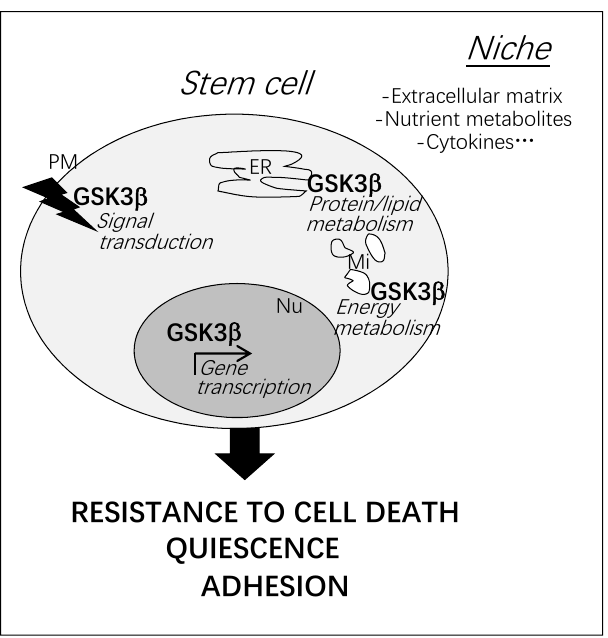
Figure 1. Multiple cellular localization of GSK3 β activation and consequences on stem cell status. At the plasma membrane, GSK3 β is critical to counteract death-signaling pathways induced by cytokines and adhesion changes in injured microenvironment. In case of nutrient or oxidative stresses, GSK3 β can adjust metabolic activities in the endoplasmic reticulum and in mitochondria. Cell survival and metabolism are tightly linked and their cross-regulation is particularly important in subcellular compartments where GSK3 β is found. In the nucleus, GSK3 β − modulated gene transcription contributes to shape the resistant phenotype of stem cells. Localized signaling activities responsible for GSK3 β activation are complex as well as the relationship between them [1]. PM: Plasma membrane; ER: Endoplasmic reticulum; Mi: Mitochondria; Nu: